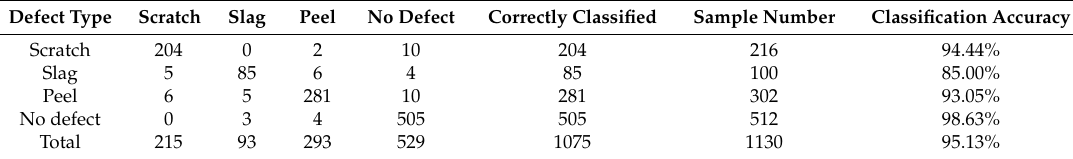
Table 4. Confusion matrix using ELM with 256-dimensional feature vectors.